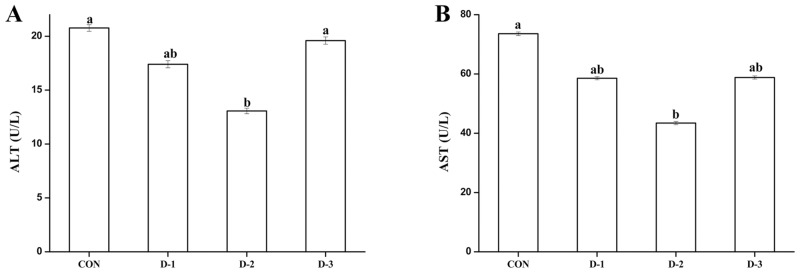
Effects of DMG-Na on ALT (A) and AST (B) activities in mice serum.Values are mean ± SEMs (n = 10). Mean of a variable without a common letter differ, P < 0.05. Alanine aminotransferase (ALT); Aspartate aminotransferase (AST). CON, gastric intubation in mice with 0 mg DMG-Na/0.3 ml sterile saline solution; D-1, gastric intubation in mice with 9 mg DMG-Na/0.3 ml sterile saline solution; D-2, gastric intubation in mice with 12 mg DMG-Na/0.3 ml sterile saline solution; D-3, gastric intubation in mice with 15 mg DMG-Na/0.3 ml sterile saline solution.